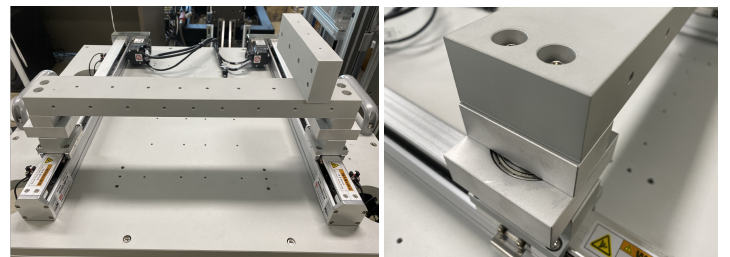
Figure 6. A dual-actuator gantry testbed.